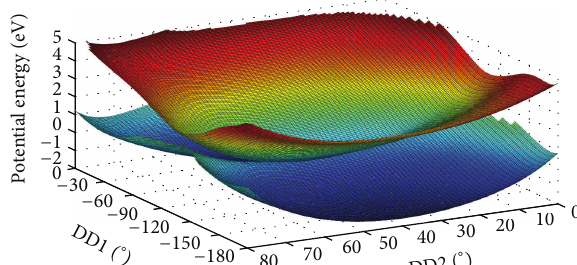
Figure 2: Analytical two-dimensional PESs for the ground state 𝑆 0 and the first excited state 𝑆 1 with respect to the combined internal angles DD1 and DD2 [33].